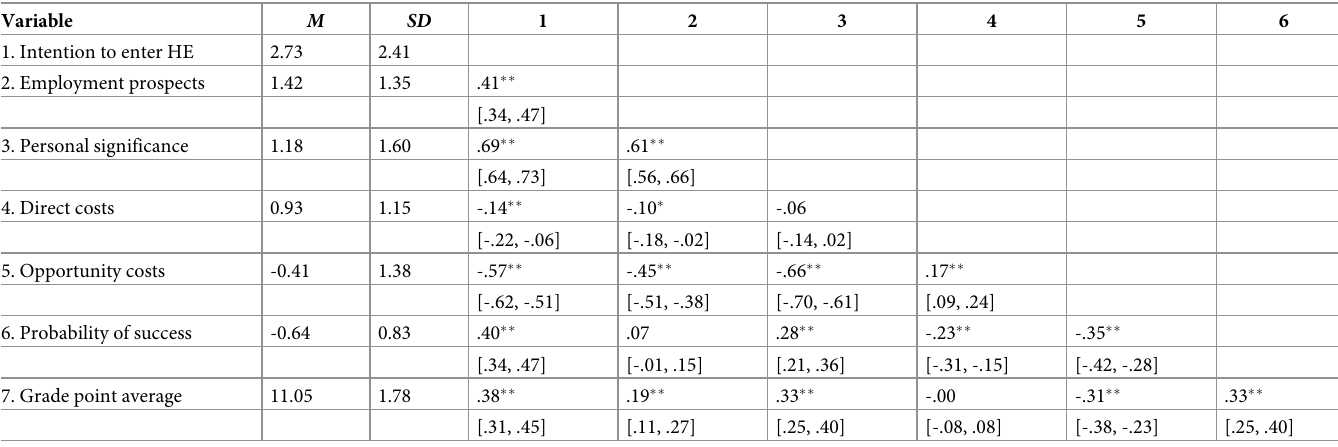
M and SD are used to represent mean and standard deviation, respectively. Values in square brackets indicate the 95% confidence interval for each correlation.